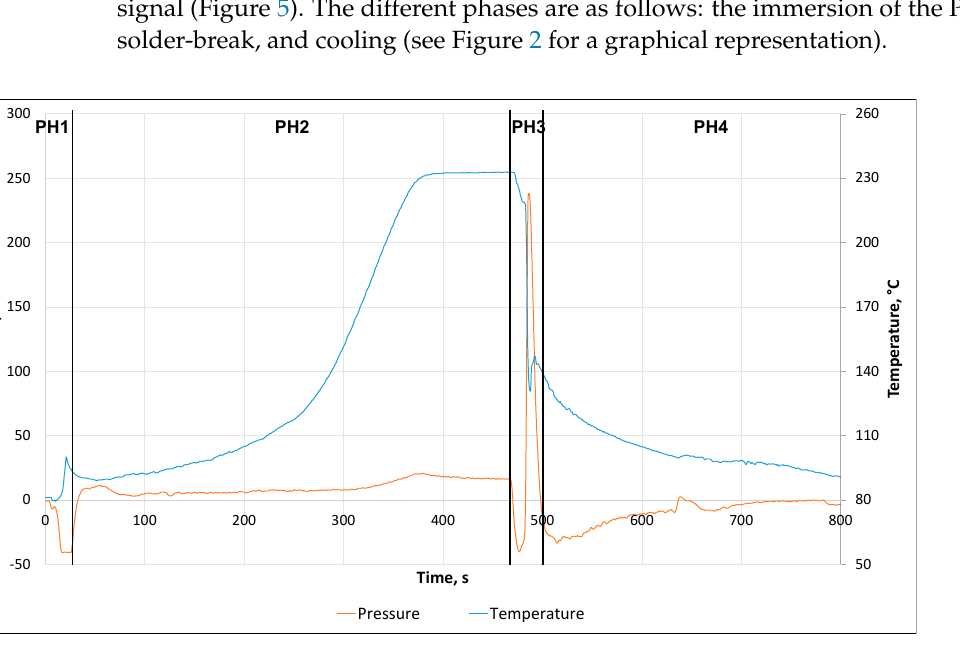
Figure 5. The phases of the heating profile during the soldering process. Phase 1 (PH1) represents the immersion of the carrier lift to the depth of the workspace after the closure of the cover (initial state). The pressure decrease is due to the downward movement of the colder carrier, which causes vapour condensation and perturbs the initial state around the heater at the bottom. It should be noted that this phase is approximately similar for every setting, even if the heating power or other process parameters are changed.